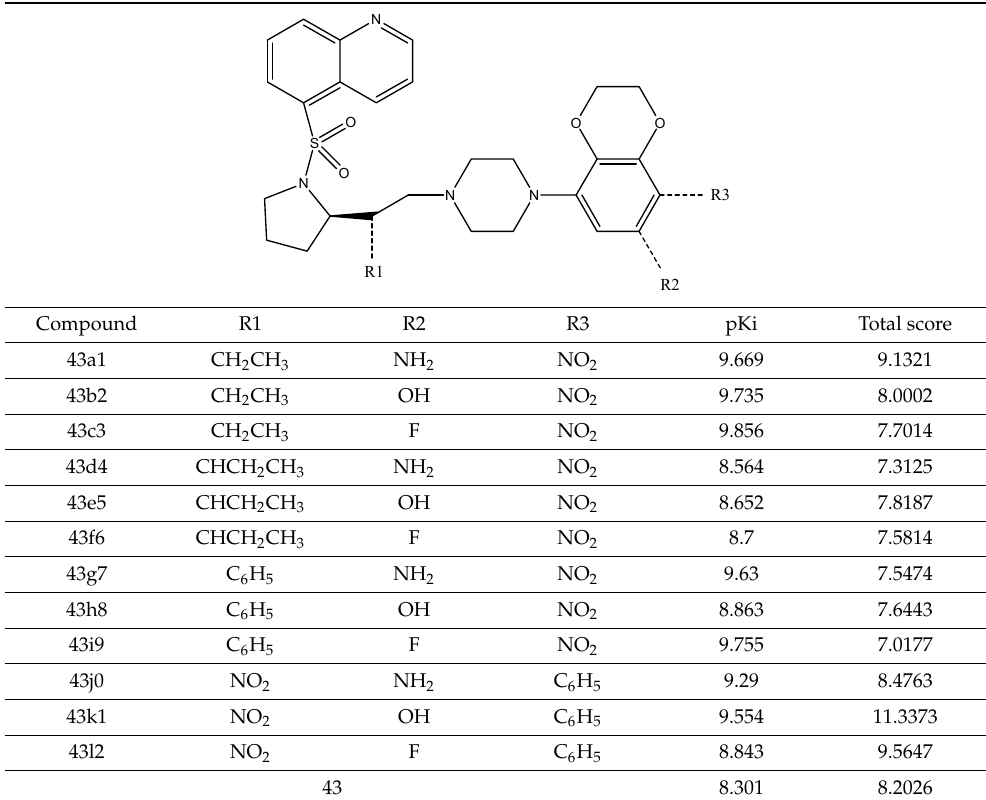
Table 3. The designed compounds and predicted pKi values.